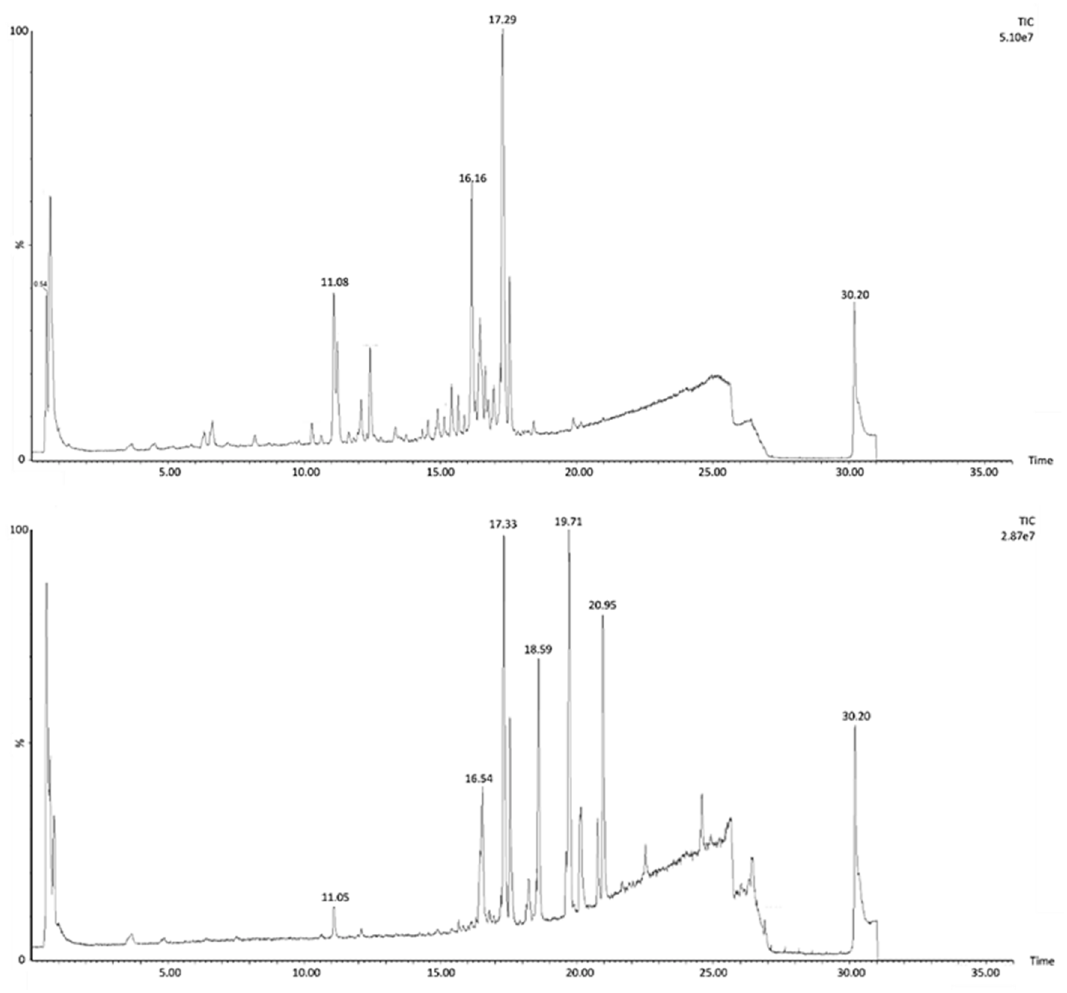
Figure 4. Total ion chromatogram in negative ion mode of H. hirsuta before and after biotransformation.